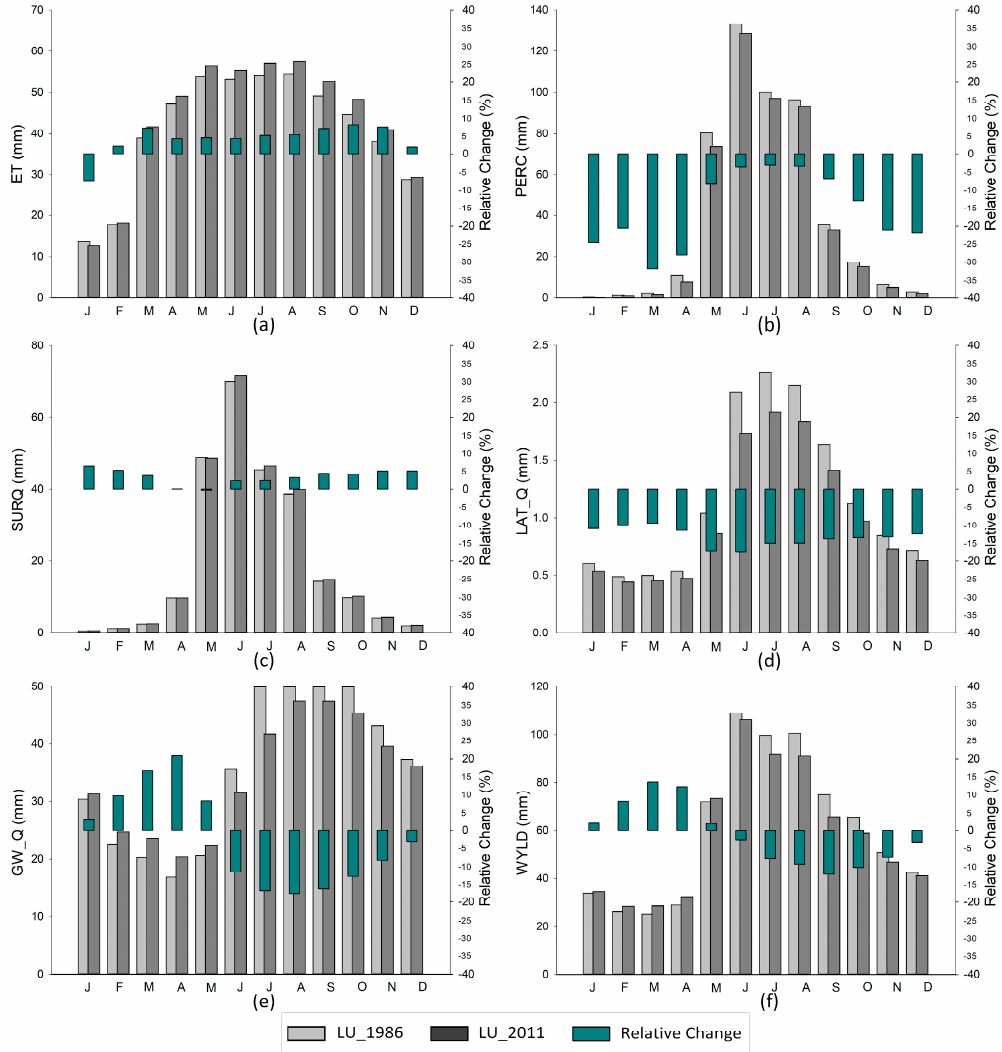
Figure 7. Monthly averages and relative changes of ( a ) ET, ( b ) PERC, ( c ) SURQ, ( d ) LAT_Q, ( e ) GW_Q and ( f ) WYLD for scenarios LU_1986 vs.